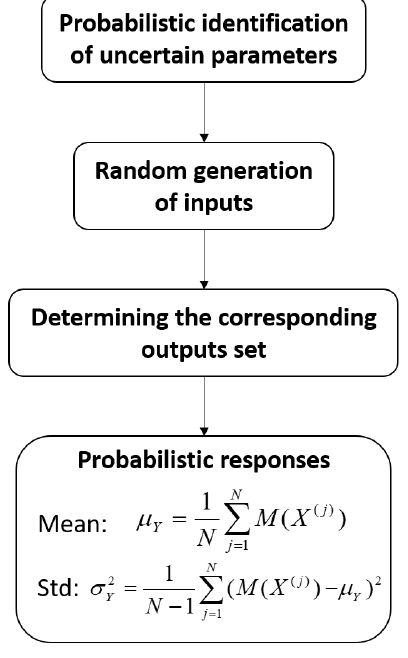
Figure 2. Flowchart of the